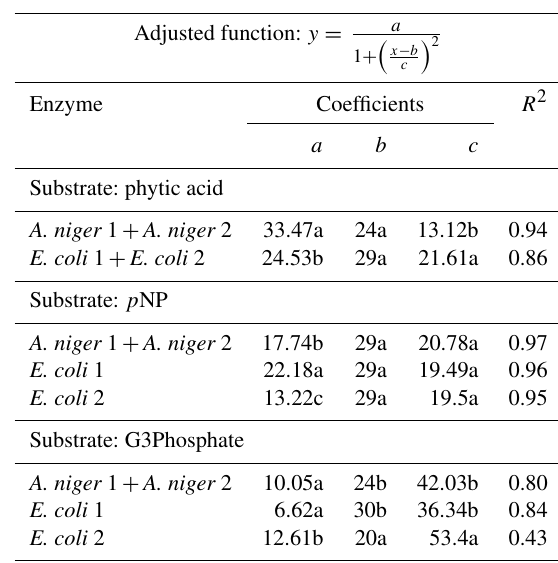
Table 3. Coefficients of the adjusted Lorentzian peak functions for phytase activity at different temperature levels (see graphs in Fig. 3). The substrates used were phytic acid, p NP and G3Phosphate. Four purified phytases (two isolated from A. niger and two from E. coli ) were evaluated. In cases where significant differences between en- zymes (analyzed using F tests) were not found, a unique curve was fitted. Different letters correspond to significant differences between treatments ( P< 0 . 05, LSD procedure).